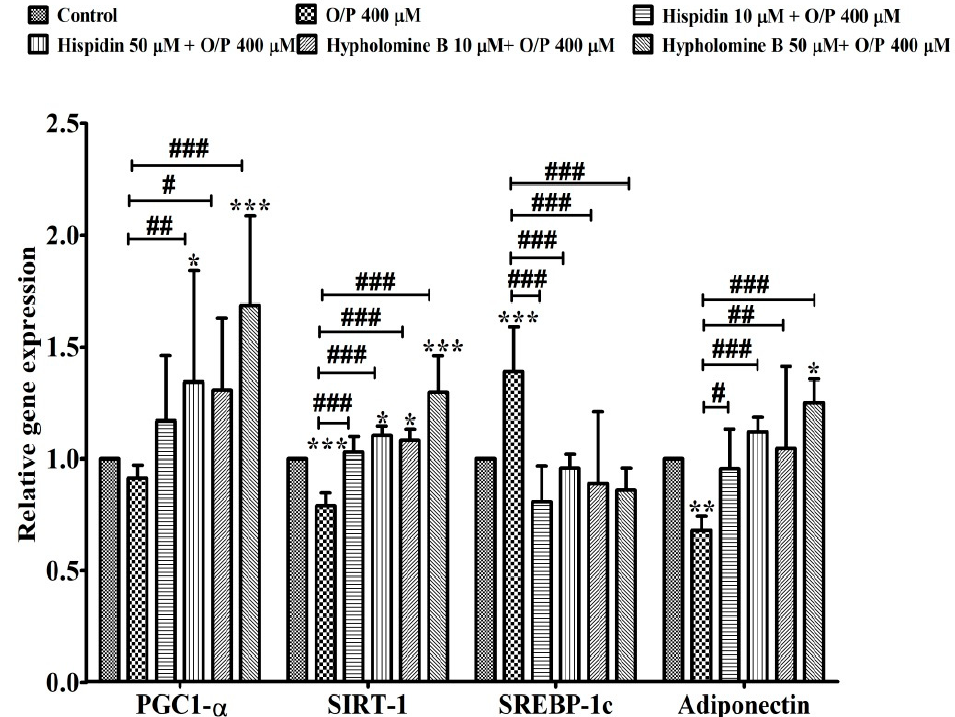
Figure 10. Effects of hispidin and hypholomine B isolated from the ethyl acetate fraction of P . linteus mycelia on the relative gene expression of HepG2 cell. Data are expressed as mean ± SE ( n = 3). *, **, and ***, p < 0.05, 0.01 and 0.001, respectively vs. the control; # , ## and ### , p < 0.05, 0.01 and 0.001, respectively vs. the O/P group. PGC1- α : peroxisome proliferator-activated receptor gamma coactivator 1-alpha; Sirt-1: NAD-dependent deacetylase sirtuin-1; SREBP-1c: sterol regulatory element-binding protein 1c.